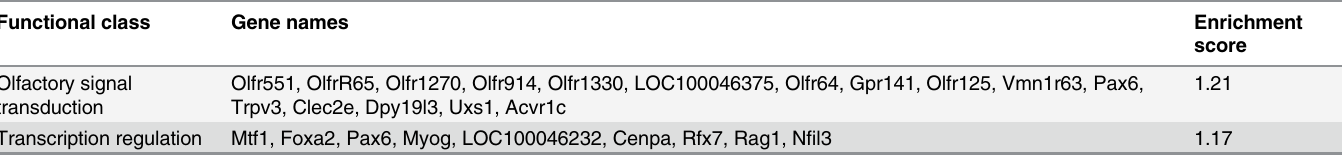
Table 1. Gene ontology terms overrepresented within genes differentially regulated in Nfil3 KO mice.